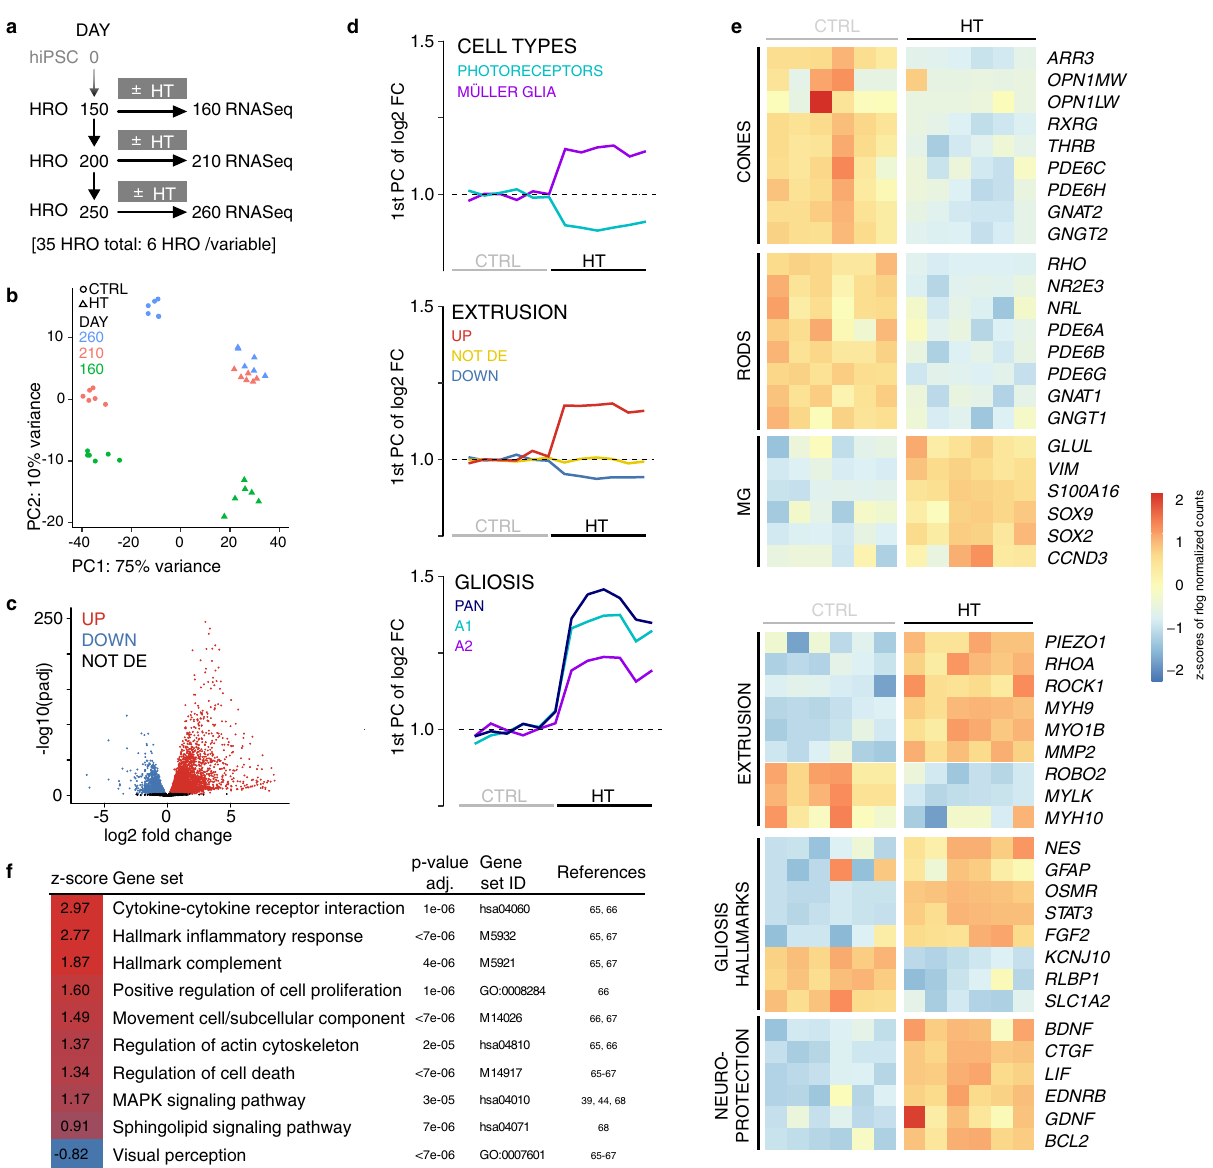
representingretinalcelltypes(photoreceptorsandMüllerglia(MG)),cell-extrusion regulators,andgliosis(markerforpan-gliosis,A1andA2states). e Heatmapsdepict Z -scores of rlog-transformed counts of genes expressed at D210 selected from the speci fi ed GOIs that are differentially expressed in HT versus CTRL HROs. f Ensemble of Gene Set Enrichment Analysis (EGSEA): selected examples of sig- ni fi cantly enriched terms (e.g., biological functions or signaling pathways) in the HT-HRO model (Supplementary Data 5a) overlap with gene sets previously repor- ted in relation to AMD (references indicated). The Z -score (red, up; blue, down) states how many standard deviations a given score deviates from the population ’ s mean. Data have been deposited on Gene Expression